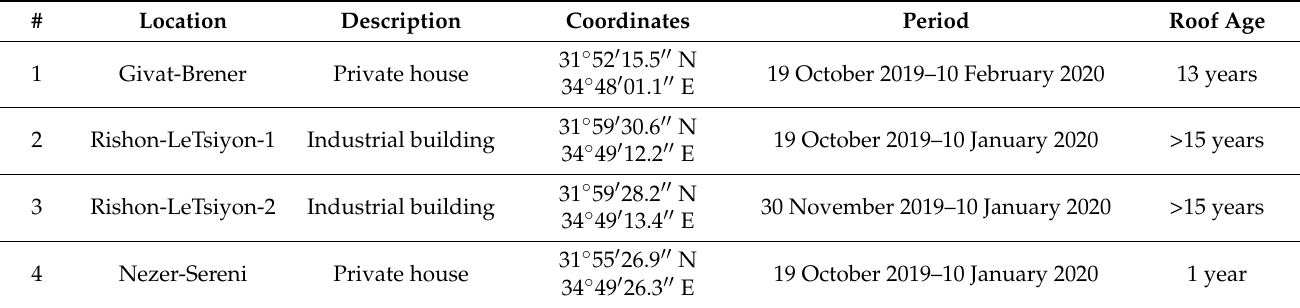
Table 1. Locations of the four roofs used for water sampling.